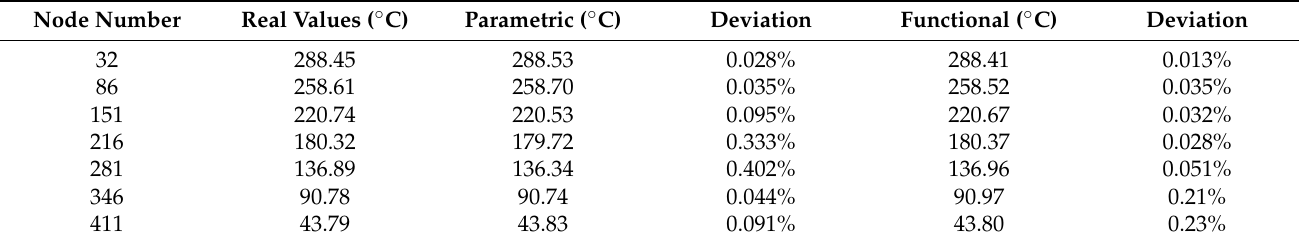
Table 8. Comparison of temperature distribution based on the two methods.